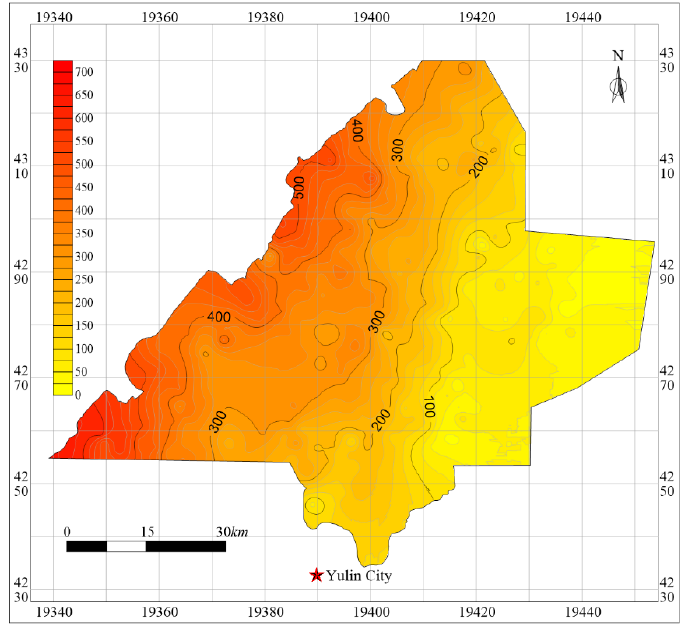
Figure 3. Overburden thickness contour (Xi’an geodetic coordinate system 1980; in km).